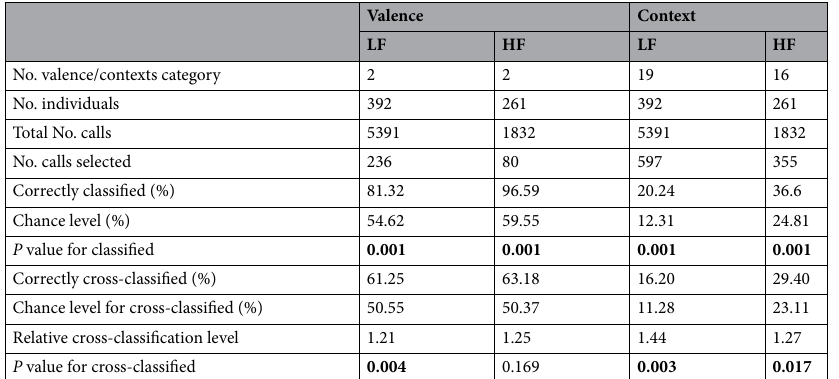
Table 1. Correct classification of calls according to the valence and context of production by the pDFA. Results of the permuted discriminant function analysis (pDFA) for low-frequency calls (LF) and high- frequency calls (HF); number of valence or contexts included, number of individuals, total number of calls, number of calls selected, percentage of calls classified and cross-classified to the correct valence or context, and corresponding chance level (expected percentage of correctly classified calls based on the permutation test, averaged across the permutations), relative classification (percentage of calls cross-classified/chance level), and p value. The analysis was performed on the entire dataset, after excluding missing data (Sample size: calls in which AMRate could not be measured = 191; calls in the entire dataset = 7414; calls included for this analysis = 7223). Significant p values appear in bold.